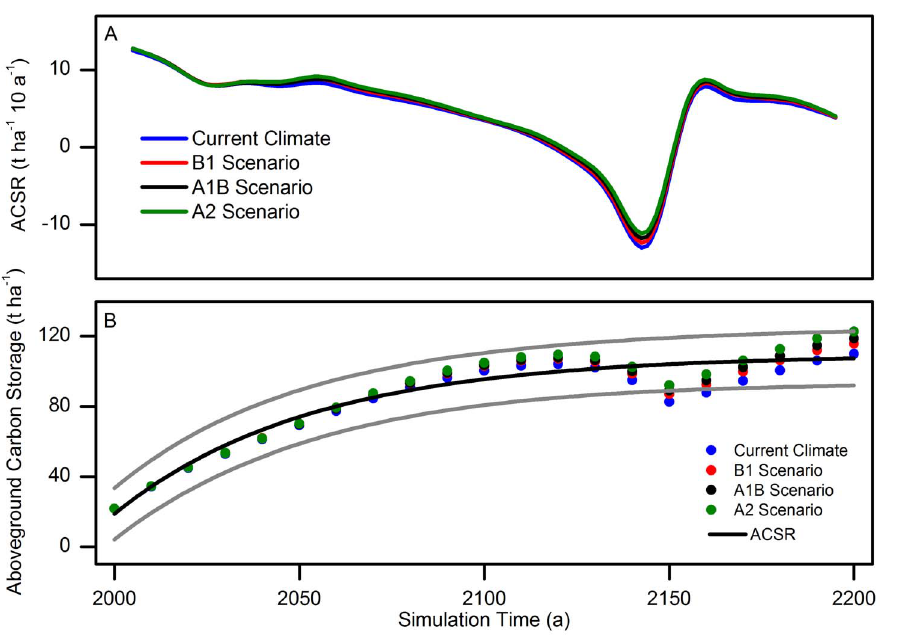
Figure 8. Total forest carbon sequestrations and its rate under various climate scenarios in simulation time. A: Forest total ACSR of different future climates. B: Forest aboveground carbon storage of different future climates. The black line means the average aboveground carbon storage of all possible future climates, and the grey lines indicate the forecasting interval of aboveground carbon storage with the confidence level of 95%.